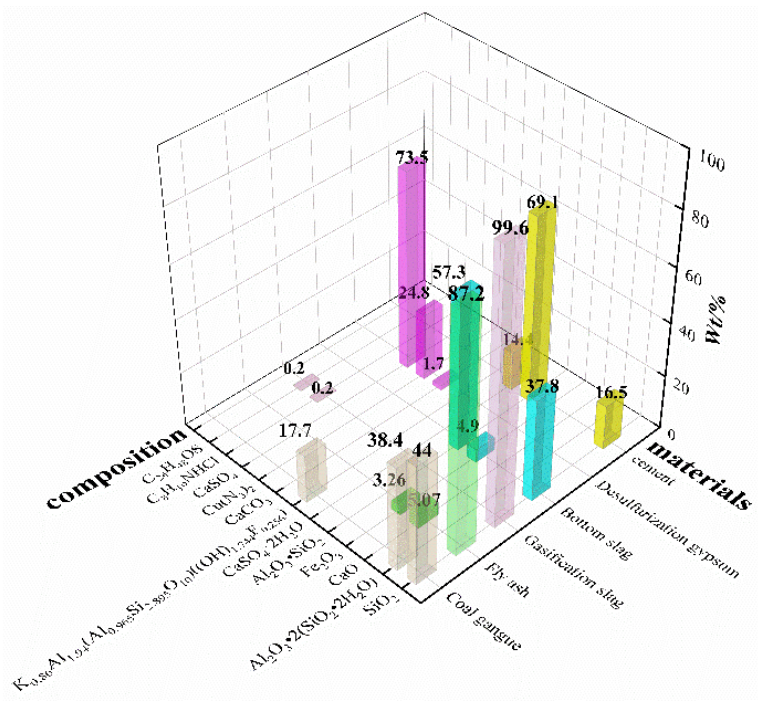
Figure 3. Analysis of main components of coal-based solid waste filling materials.